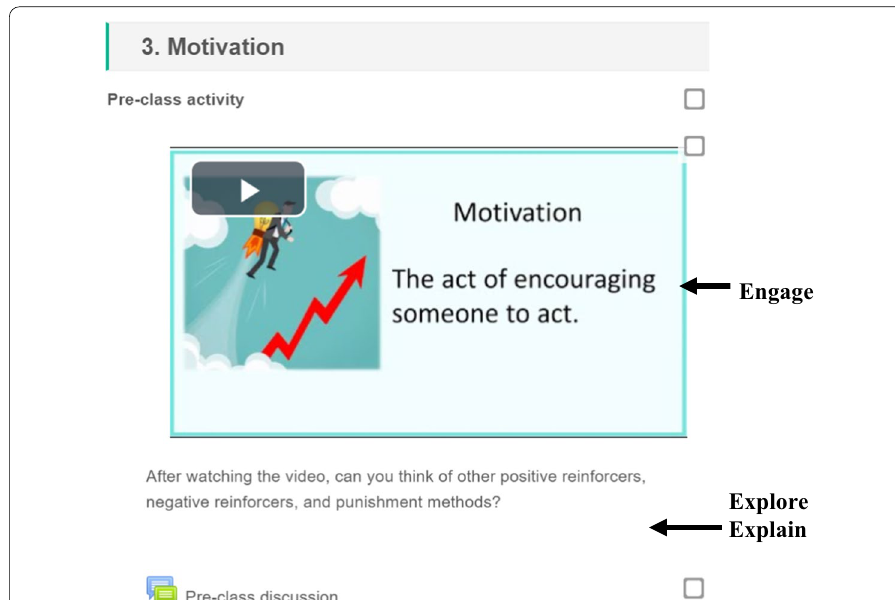
Fig. 5 Example of a pre-class activity in Course 2